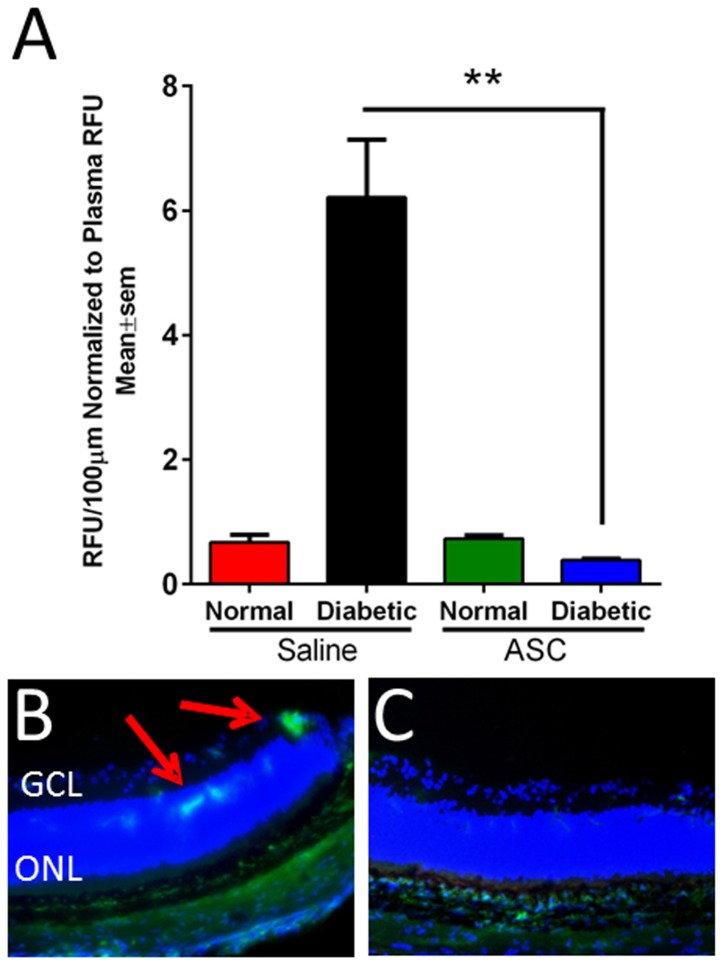
Increase in vascular permeability in diabetic athymic nude rats is alleviated with intravitreal ASC injection.(A) Two months post diabetes induction or age matched normal rats were injected intravitreally with saline (n = 8–10/group) or ASC (n = 6–8/group; 250,000 cells in 2 µL of saline). At day 7, rats were injected with 100 mg/kg of FITC-BSA via tail vein. After 1hr, rats were euthanized and perfused with 4% paraformaldehyde, and eyes enucleated and embedded. About ten 10 µm sections of equal area were analyzed for FITC fluorescence and normalized to total plasma fluorescence. A significant (**p<0.01) increase in leakage in diabetic rats was alleviated by ASC injection. Representative immunofluorescence image of a diabetic retina received saline (B) and diabetic retina treated with ASC (C) showing leakage (20× original magnifications). RFU = Relative fluorescence units.